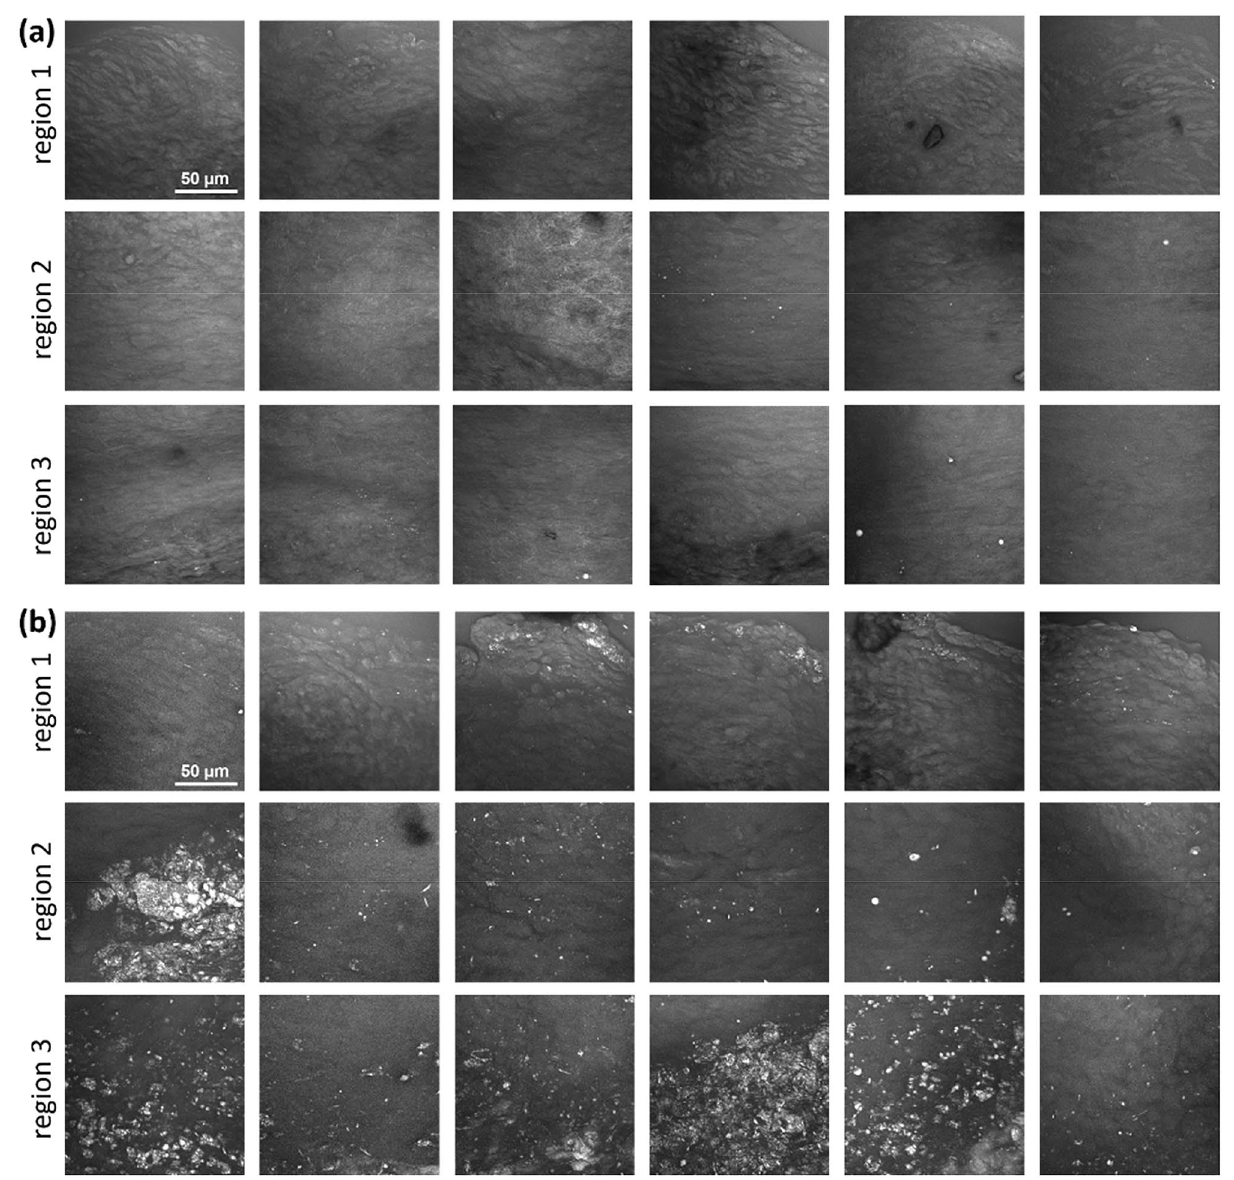
Figure 6. CARS images of acoronary leaflets acquired in the region 1, 2 and 3. ( a ) WT mice. ( b ) ApoE −/− mice. All images are maximum intensity projections of the stacks acquired through the entire leaflet thickness and have the dimensions of 140 µm × 140